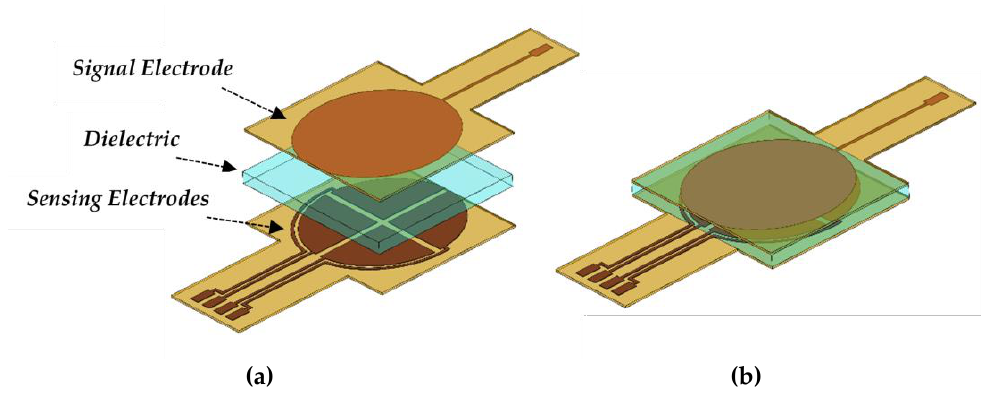
Figure 1. ( a ) Schematic of the capacitive sensor. ( b ) Capacitive sensor after